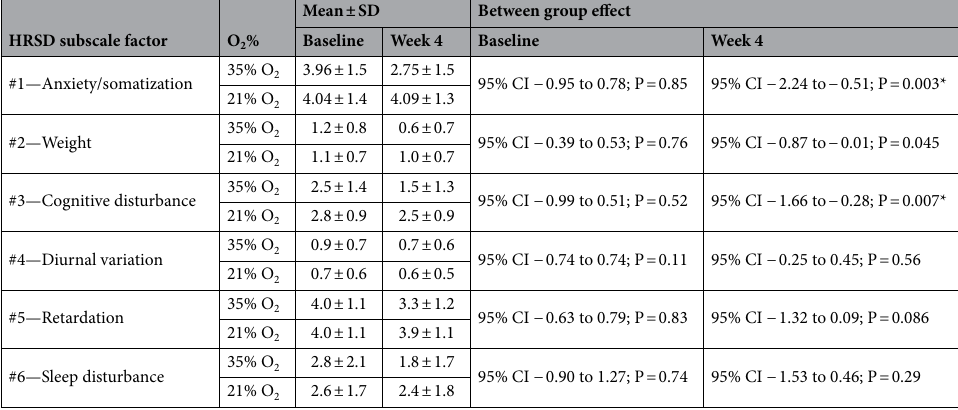
HRSD subscale factor O 2 %